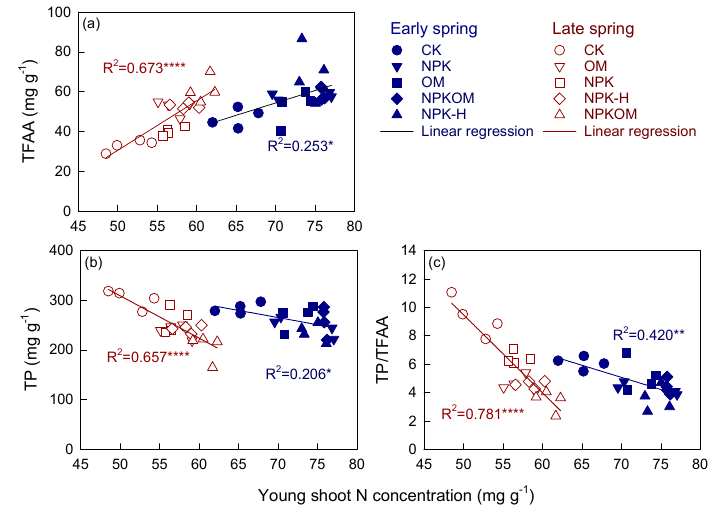
Figure 5. Response of total free amino acid (TFAA, a ), total polyphenol (TP, b ), and the ratio of TP/TFAA ( c ) to N concentration in young shoots in the early (open symbols) and the late spring (closed symbols). Linear regression lines are indicated with R 2 values and significance levels (*, p < 0.05; **, p < 0.01; ****, p < 0.0001). Compared to CK, fertilization significantly reduced the content of total polyphenol (TP) in young shoots (Figure 4c). The greatest decrease was found in the NPK-H and